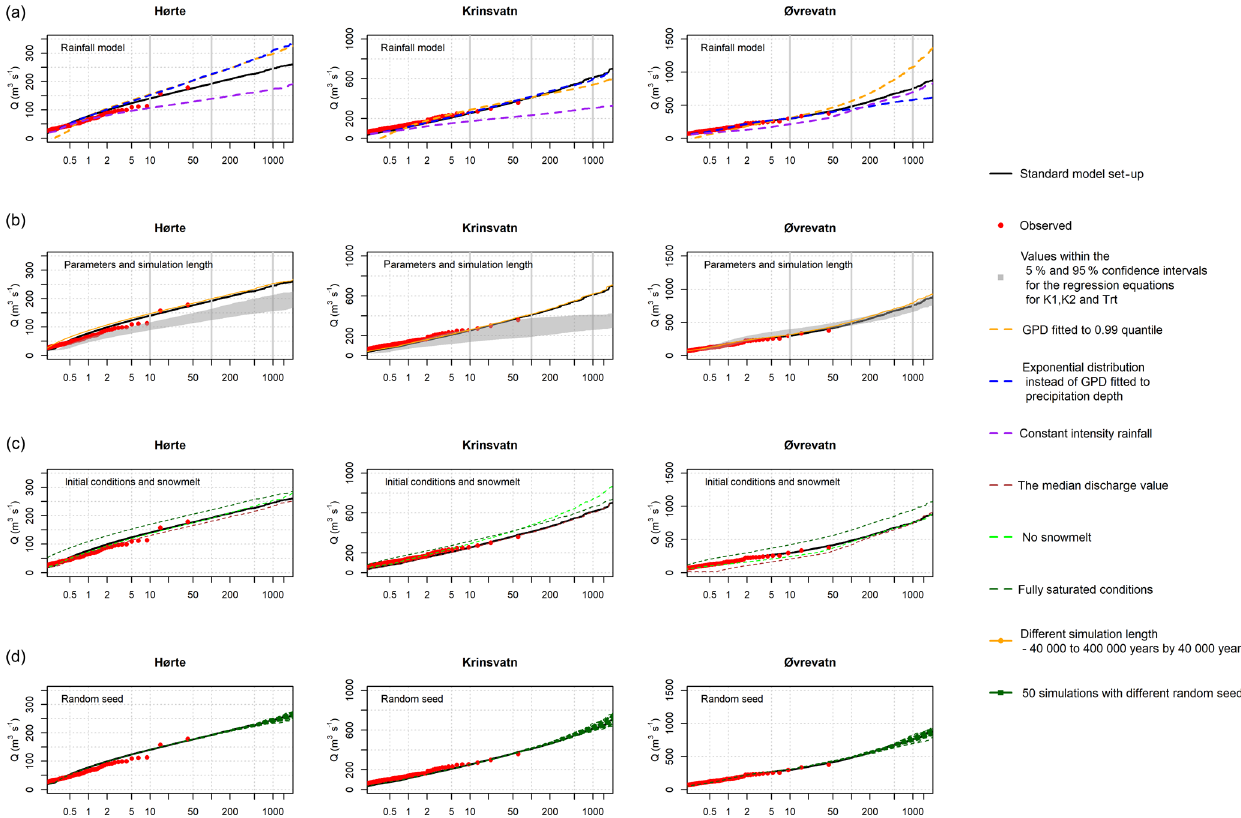
Figure 8. Sensitivity analysis of the stochastic PQRUT for the following variables: (a) the rainfall model; (b) the effect of the simulation length and the parameters of the hydrological model; (c) the initial discharge values, snowmelt conditions and catchment saturation; and (d) the random seed used for the simulations. Detailed information on the set-up is given in Table 3. Table 3. Set-up for the sensitivity analysis of